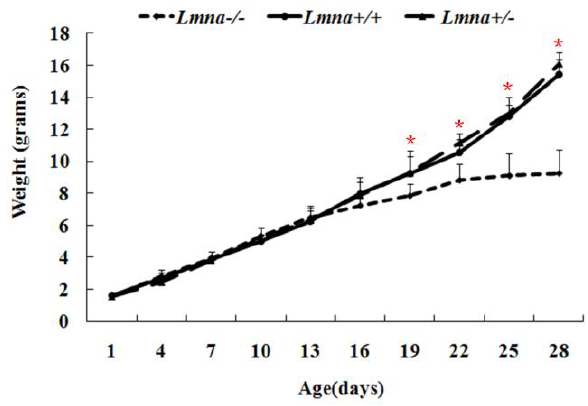
Figure 2. Growth curves of mice with different Lmna genotypes. The body weights of Lmna -/- , Lmna +/+ and Lmna +/- mice were evaluated once every 3 days from their birth (D1) to 4 weeks (D28). The data are presented as the mean  SD, n = 30. The black solid line denotes wild-type mice. The long dashed line denotes Lmna +/- mice. The short dashed line indicates Lmna -/- mice. *